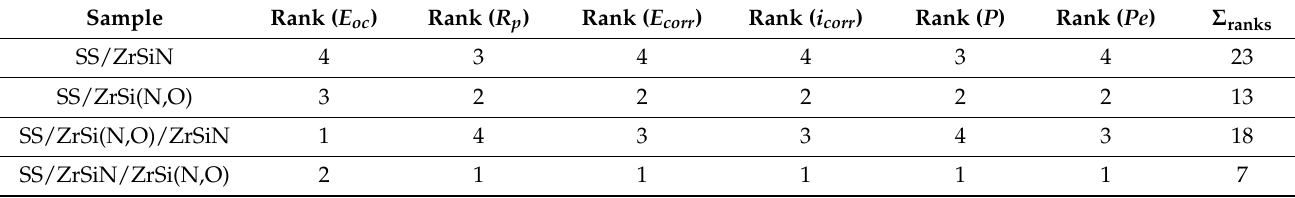
Table 3. Ranks attributed to the coated samples according to 4 corrosion